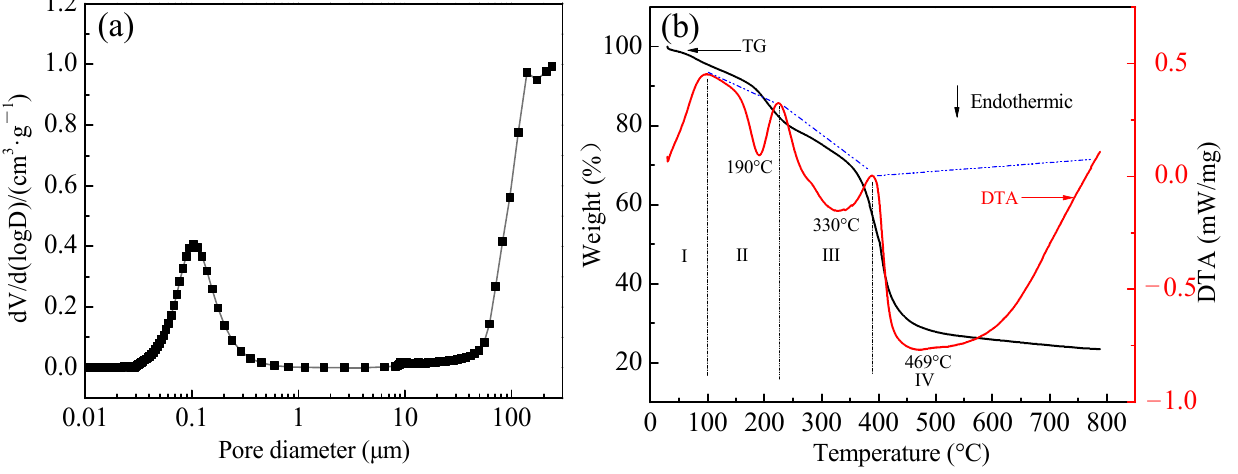
0.01 Figure 2. ( a ) Differential pore volume distribution of pores with different diameters in the WAO resin . ( b ) TG and DTA curves of WAO resin. Figure 2a shows that the total porosity of WAO resin is 49.29%, the intra-particle poros- ity is 34.56%, the interparticle porosity is 14.73%, and the pore volume is 0.65 cm 3 /g,